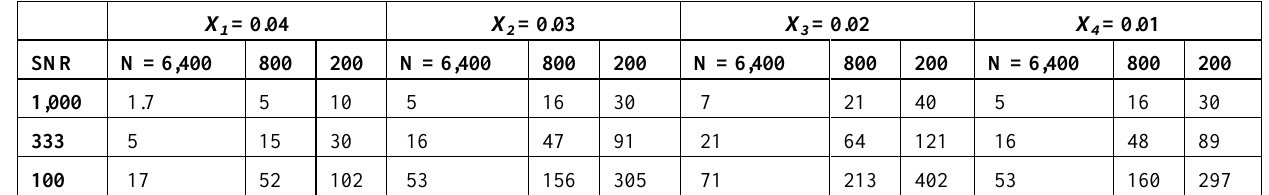
Table 1. Relative errors (%) in a case of four retrieval values in the numerical experiment that simulates investigation of aerosol structures in the boundary layer (see text).